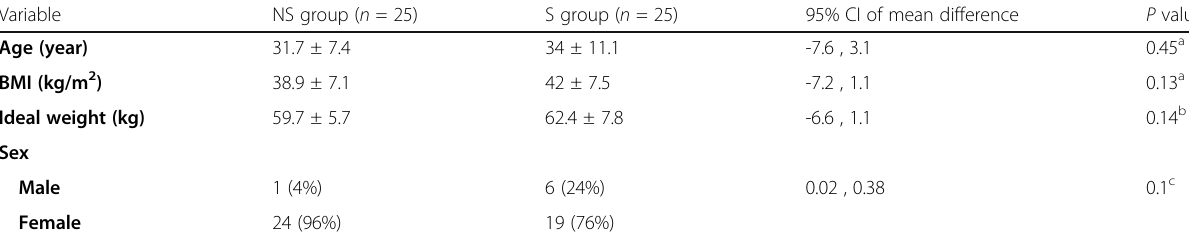
Table 1 Demographic data of the studied groups Variable